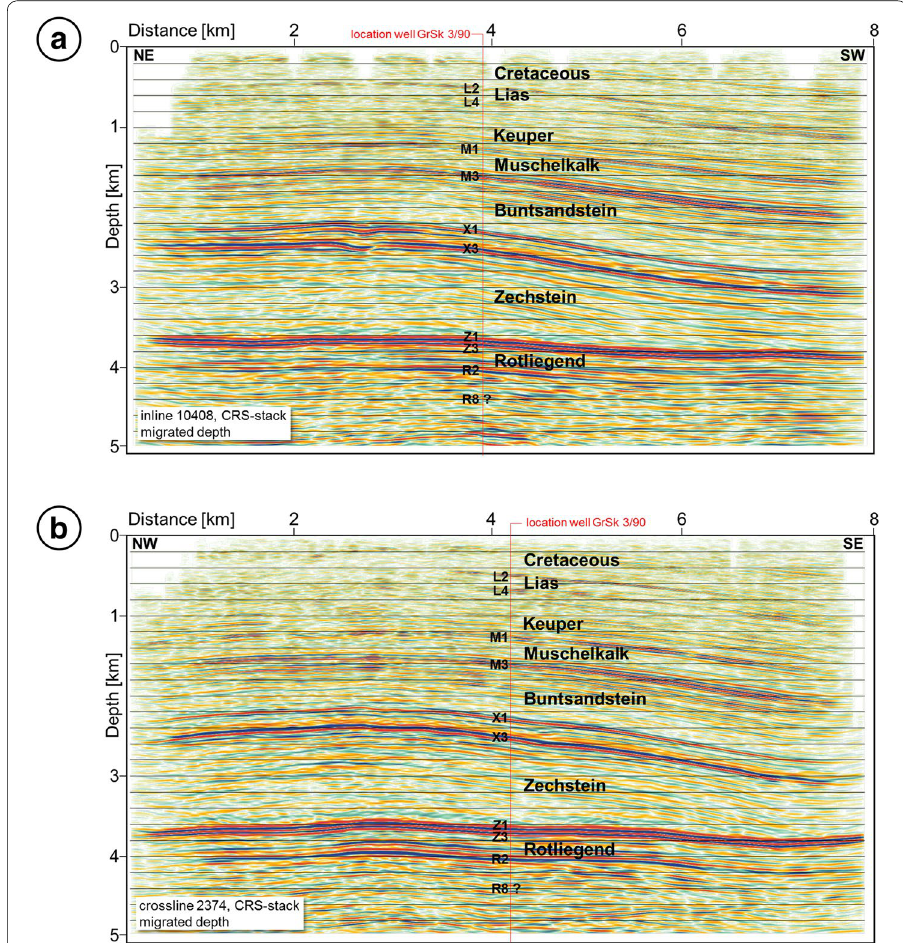
Fig. 5 Depth profiles cut from CRS-stacked and post-stack time-migrated depth-converted seismic volume. Inline 10408 ( a ) and crossline 2374 ( b ) traverse and cross at the location of the borehole (red line—location of borehole and intersection of profiles), reflectors are labeled according to stratigraphy defined in Fig.